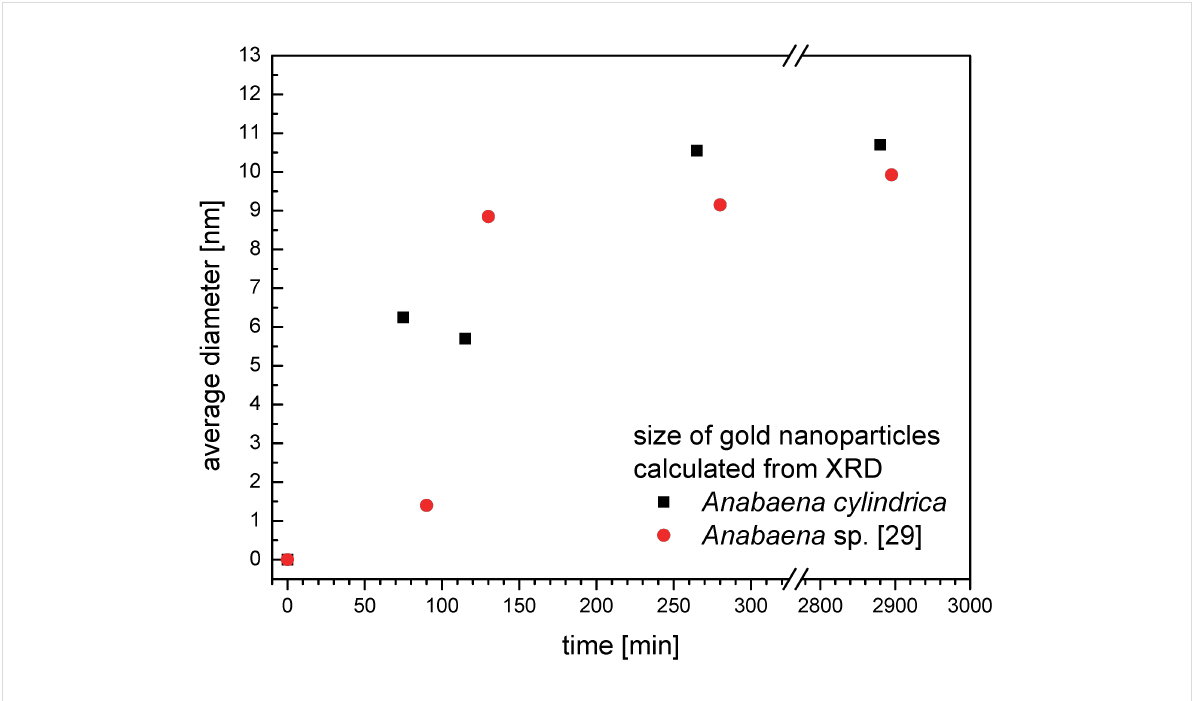
Figure 7: Average size of nanoparticles formed by Anabaena cylindrica (black squares) and Anabaena sp. [29] (red circles) calculated as average from peak (111) and (002) of the XRD signal over the time of incubation with an overall concentration of 0.8 mM Au 3+ .